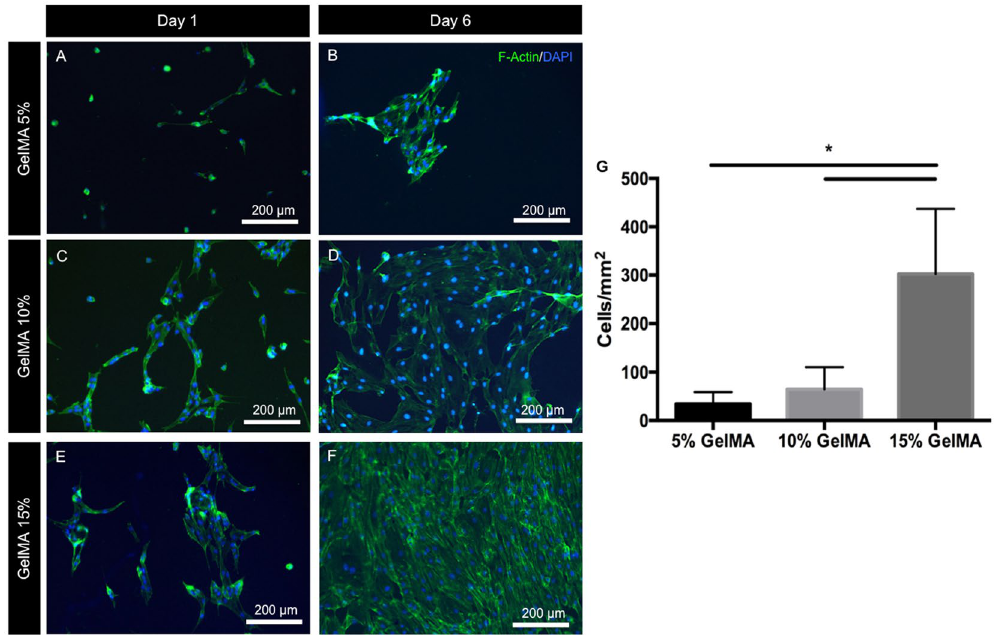
Figure 5. Cell spreading and monolayer formation by ECFCs on 2D GelMA hydrogels. Representative images of ECFCs on ( A , B ) 5%, ( C , D ) 10% and ( E , F ) 15% GelMA hydrogels after 1 and 6 days in culture, stained for actin (green) and DAPI (blue) showed increased cell spreading and cell density on stiffer substrates at both early and late time points. ( G ) Quantification of the number of cells per unit surface area on day 6, representative of cell coverage on the hydrogels and the propensity for endothelial monolayer formation suggests that stiffer GelMA hydrogel substrates support ECFC proliferation and monolayer formation. Statistical significance is represented by * for p <